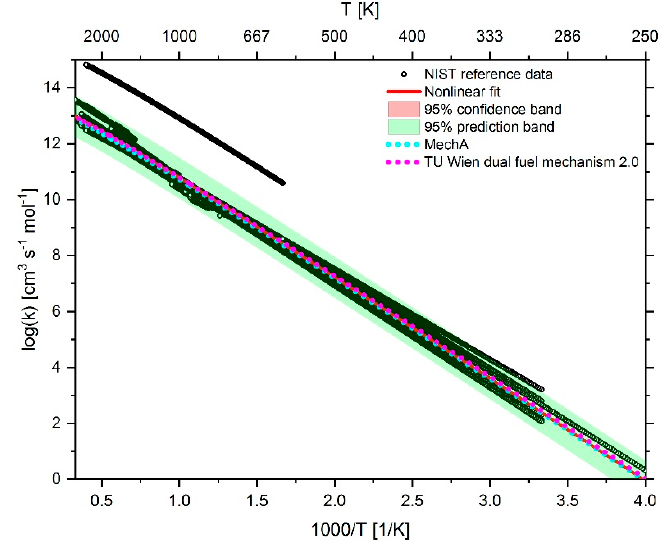
Figure 20. Comparison of the reaction rate coe ffi cient of reaction 1 (H + O 2 ↔ OH + O) of MechA and TU Wien dual fuel mechanism 2.0 as well as the fitted rate coe ffi cient using reference data from the NIST database.